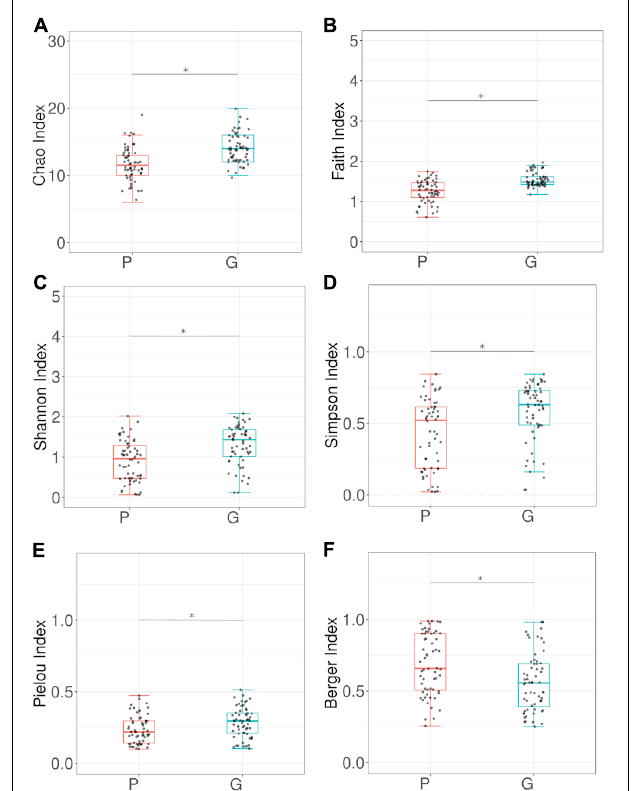
FIGURE 5 | α -diversity analyses of larval gut bacterial community associated to wild Anastrepha fraterculus . The figure presents the comparison between larvae recovered from different host species, guava (G) and peach (P). (A) Chao index; (B) Faith index; (C) Shannon index; (D) Simpson Index; (E) Pielou Index; (F) Berger Index. Dots indicate observed values and box plots depict means and standard deviation. Kruskal–Wallis Rank Sum test p -values are plotted for each paired